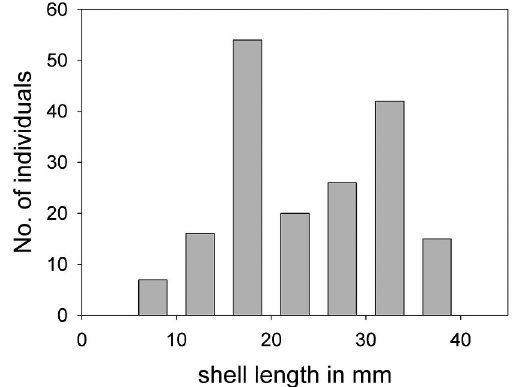
Figure 9. Size distribution of Calyptraea aurita (n = 180).